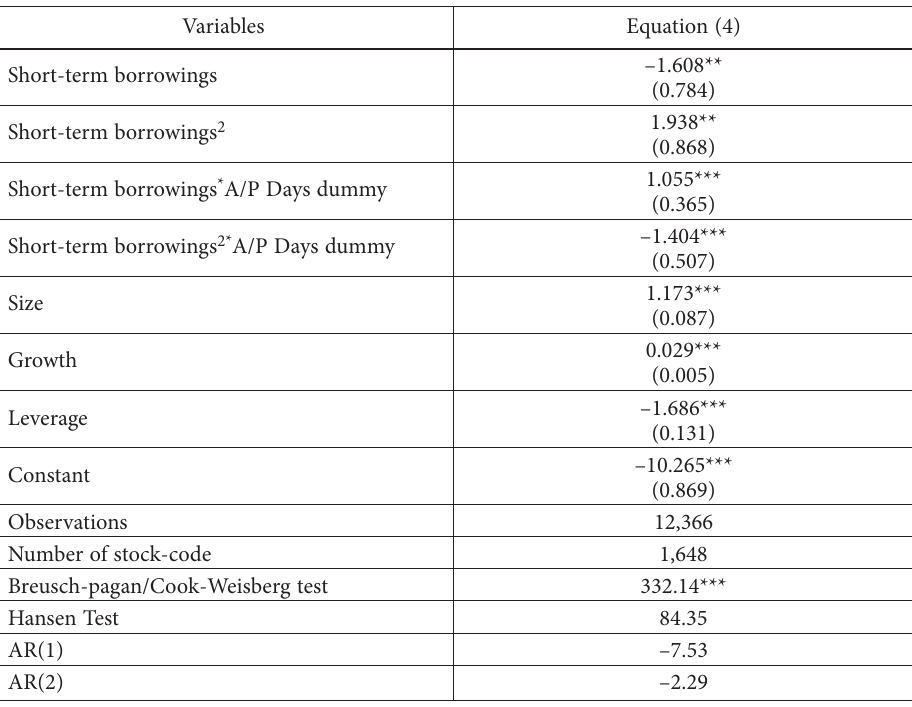
Table 6. Short-term borrowings and Profitability for firms carrying reduced and extended account payable